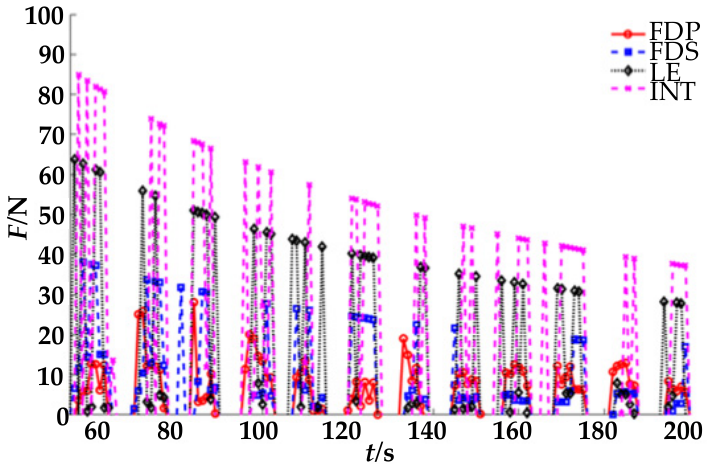
Figure 11. Four-fingertip pressure signals and muscle strength estimation results. Figure 11. Four- fingertip pressure signals and muscle strength estimation results.